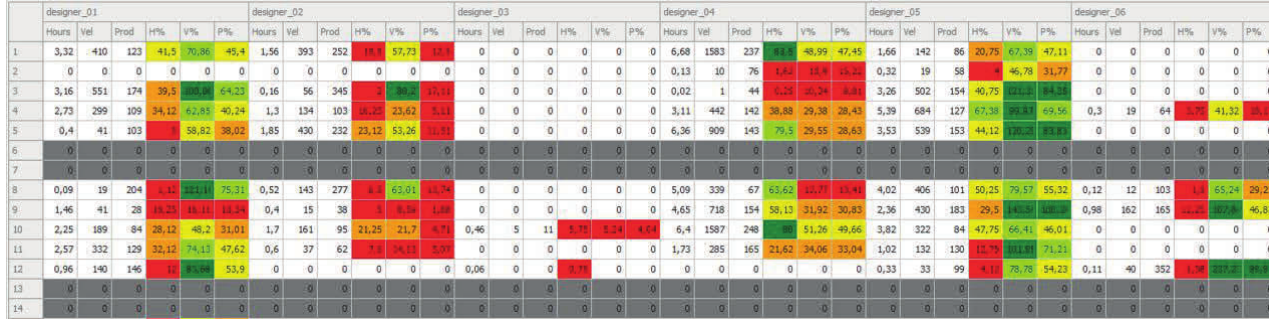
Fig. 4. An overview of efficiency metrics of all designers on a monthly basis